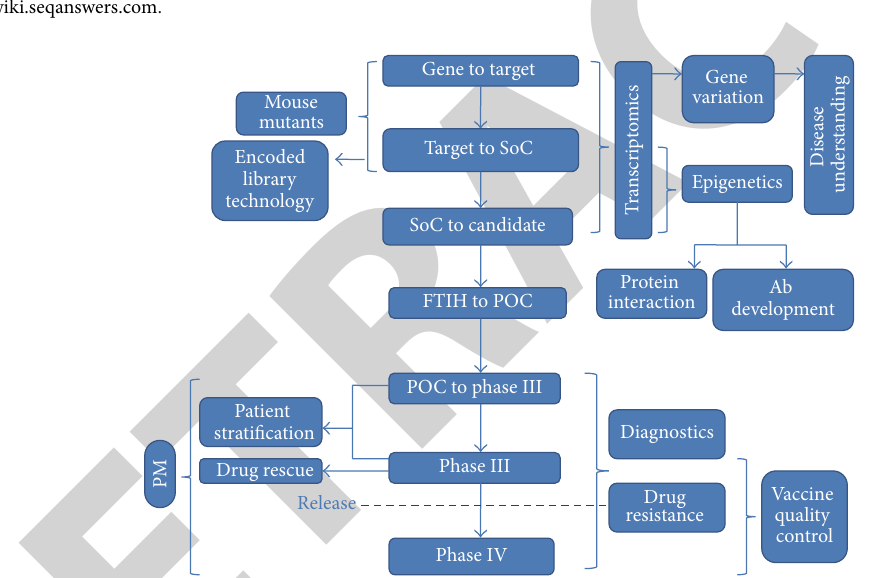
Figure 2: Application of Next Generation Sequencing in drug discovery. SoC: standard of care; POC: proof of concept; FTIH: first time in